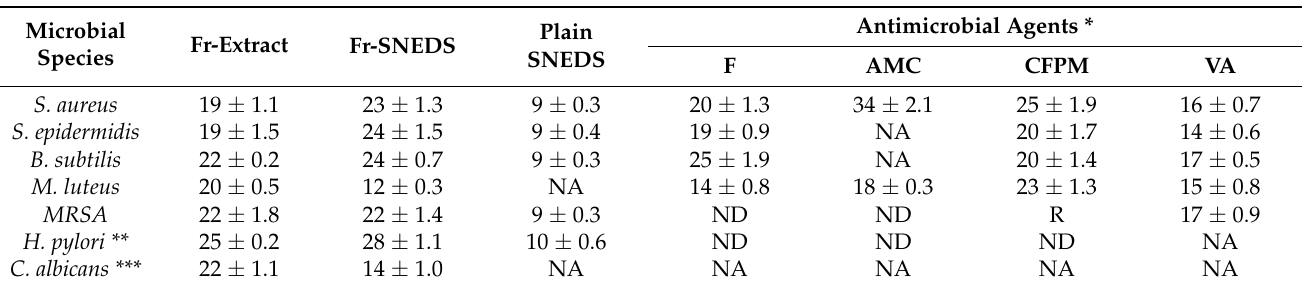
DMSO, Capryol™ 90 and Gelucire ® 44/14 showed no zones of inhibitions. NA: Not active, ND: Not determined, R: Resistant. * Antimi- crobial agents: F (Nitrofurantoin-300 µ g/disc), AMC (Amoxacillin/Clavulanic acid 20/10 µ g/disc), CFPM (Cefepime-30 µ g/disc), VA (vancomycin 30 µ g/disc). Fluconazole (150 mg) and Metronidazole (5 µ g/disc) were induced zone of inhibition of 19 and 27 mm against ** and ***,